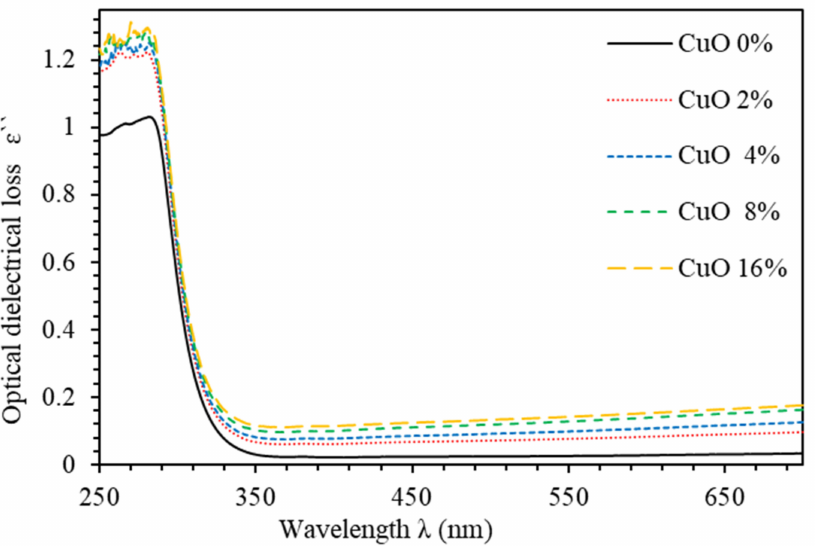
Figure 7. Optical dielectric loss ( ε (cid:48) ) spectra of PMMA–PVA/CuO nanocomposite thin films as function of wavelength for various CuO NPs